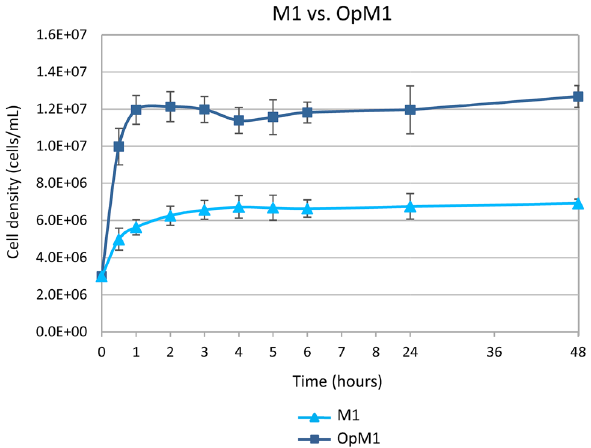
Figure 1. Growth curves of G. barretti cells of 3 individuals, cultured in M1 and OpM1 media. Error bars indicate the standard deviation from the average of biological (N = 3) and technical (n = 3)